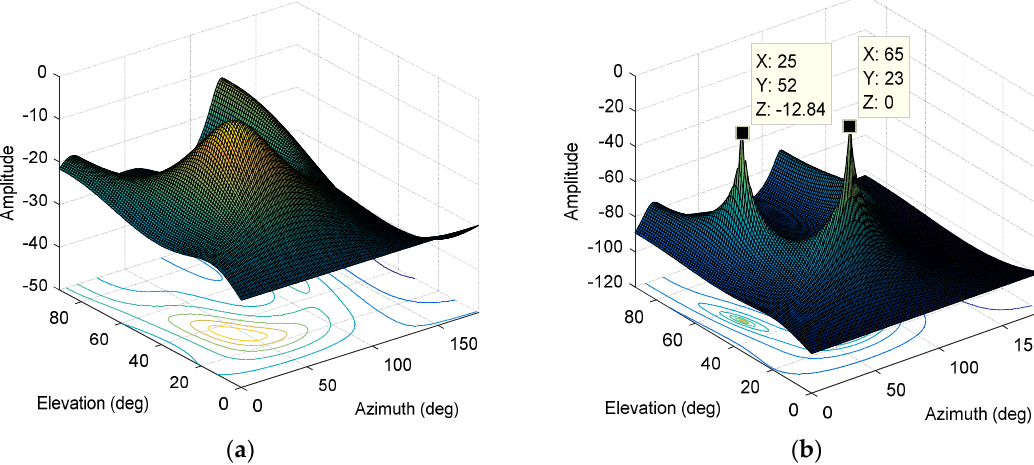
Sensors 2019 , 19 , x Figure 13. Schematic diagram of signal acquisition scheme. Figure 13. Schematic diagram of signal acquisition scheme.